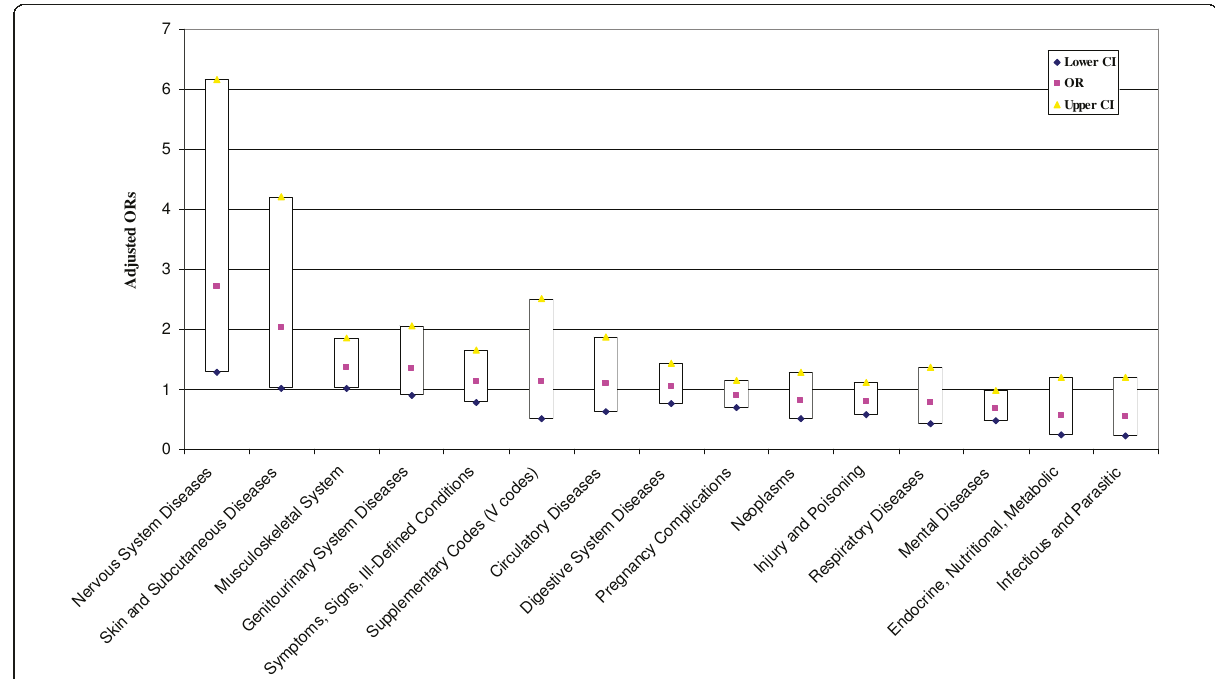
Figure 1 Adjusted odds ratios and 95% confidence intervals for odds of a hospitalization visit for illnesses by CAM use versus non- CAM use, adjusted for sex, age, education, marital status, race/ethnicity, pay grade, branch of service, and occupation .